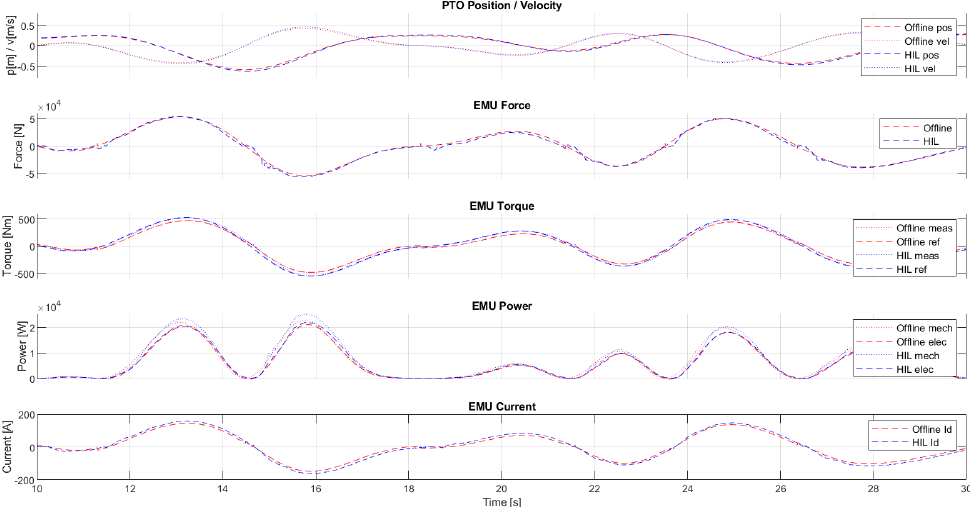
Figure 9. Comparison between offline model and HIL tests results for sea state with T p = 7s, H s =